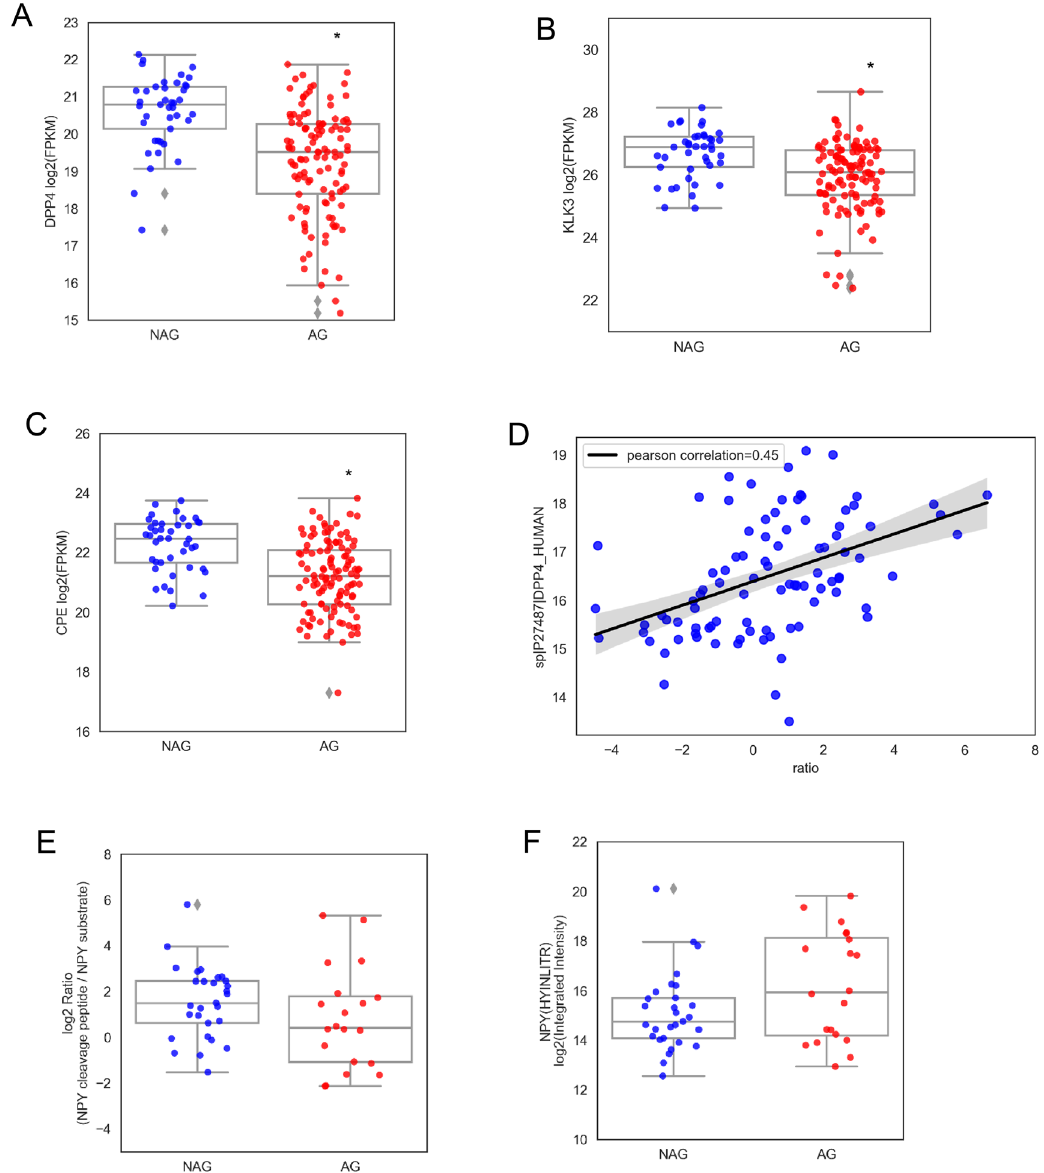
Figure 5. Loss of DPP4 transcription and activity in AG tumors. ( A ) DPP4 mRNA expression of AG tumors from TCGA dateset. ( B ) KLK3 mRNA expression of AG tumors from TCGA dataset. ( C ) CPE mRNA expression of AG tumors from TCGA dataset. ( D ) Correlation of DPP4 expression with the ratio of NPY cleaved peptide to intact substrate peptide. ( E ) The ratio of NPY cleaved peptide to intact substrate peptide in AG tumors. ( F ) Total NPY peptide expressions between NAG and AG tumors. * P <